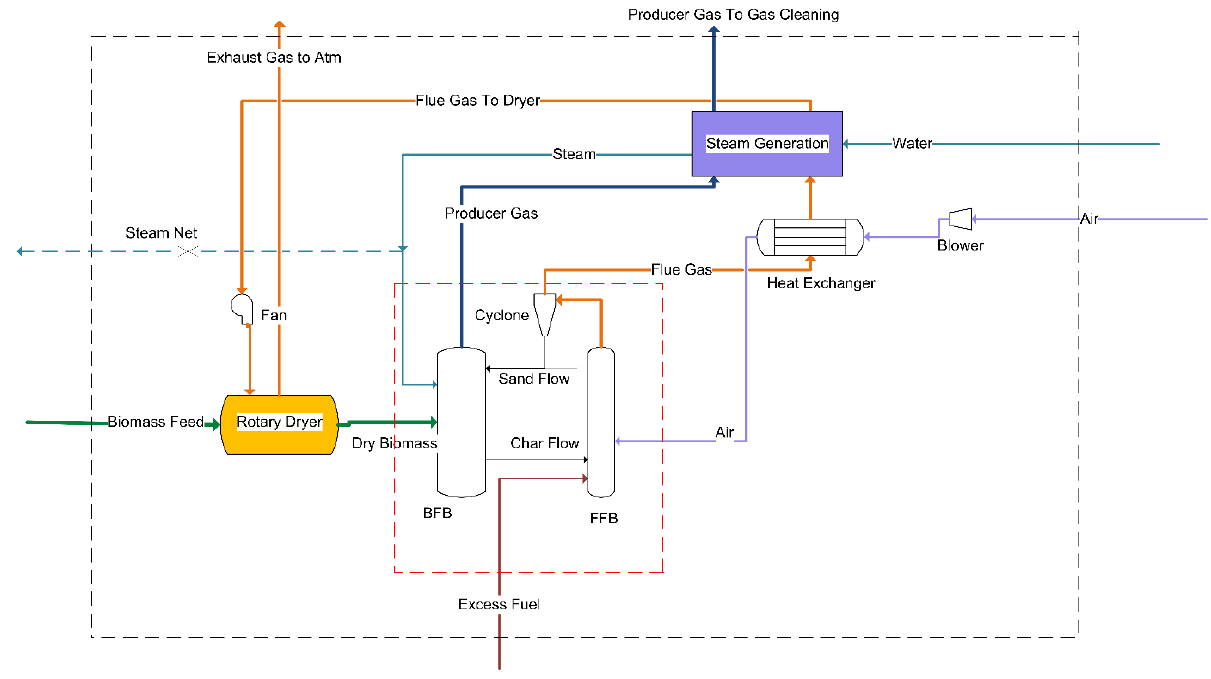
Figure 1. Process diagram of the integrated system of biomass drying and dual fluidized bed (DFB) biomass